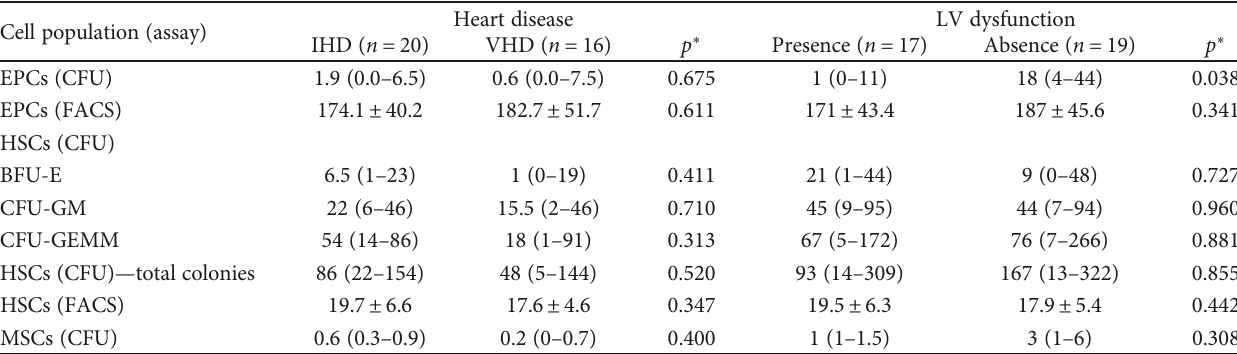
Figure 2: Analysis of the endothelial progenitor cell compartment. (a) CFU-hill colony (original magni fi cation: × 200). (b) Flow cytometry (FACS) and the colony assay (CFU) showed a good correlation in the determination of EPC Frequencies. Scale bar: 100 μ m. Table 2: Frequency of endothelial progenitor cells, hematopoietic stem cells, and mesenchymal stem cells in the sternal bone marrow samples from patients with ischemic or valvular heart disease, in presence or absence of left ventricular dysfunction. Cells were analyzed by colony assay (CFU) and fl ow cytometry